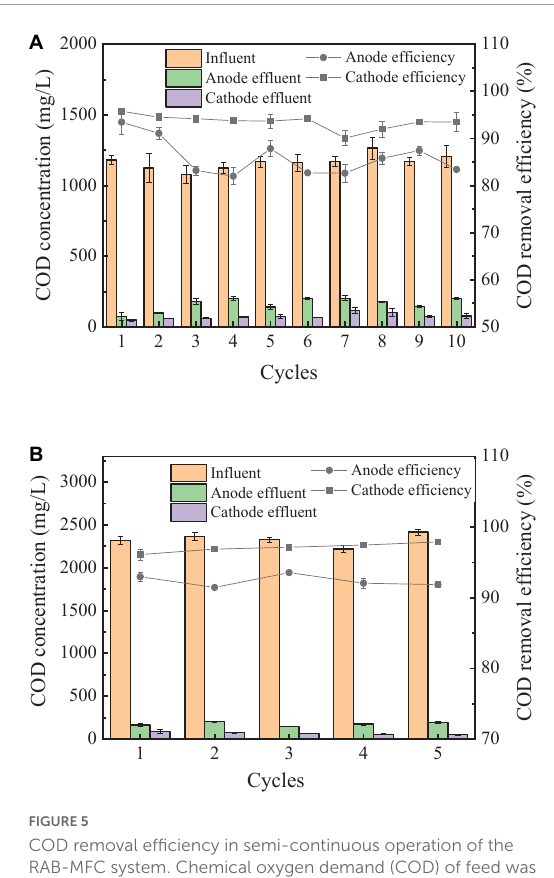
FIGURE5 COD removal efficiency in semi-continuous operation of the RAB-MFC system. Chemical oxygen demand (COD) of feed was 1,200 mg/L (A) , and 2,400 mg/L (B) .